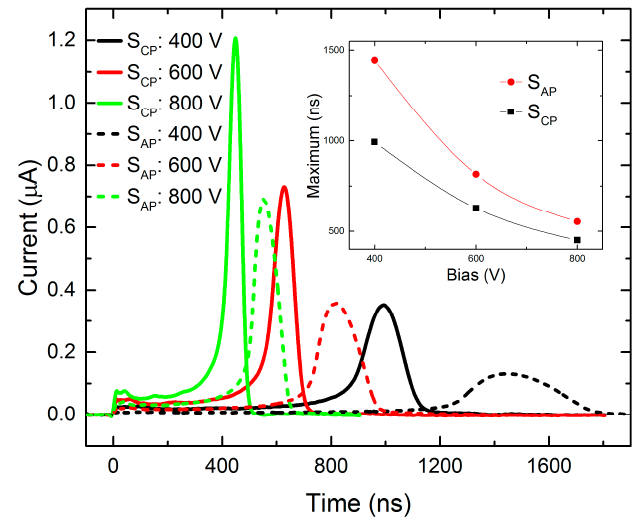
Figure 4. Bias dependence of current waveforms measured on a single CP anode when illuminating S CP or S AP . Inset shows the bias dependence of the time of maximum current after illuminating given spots.